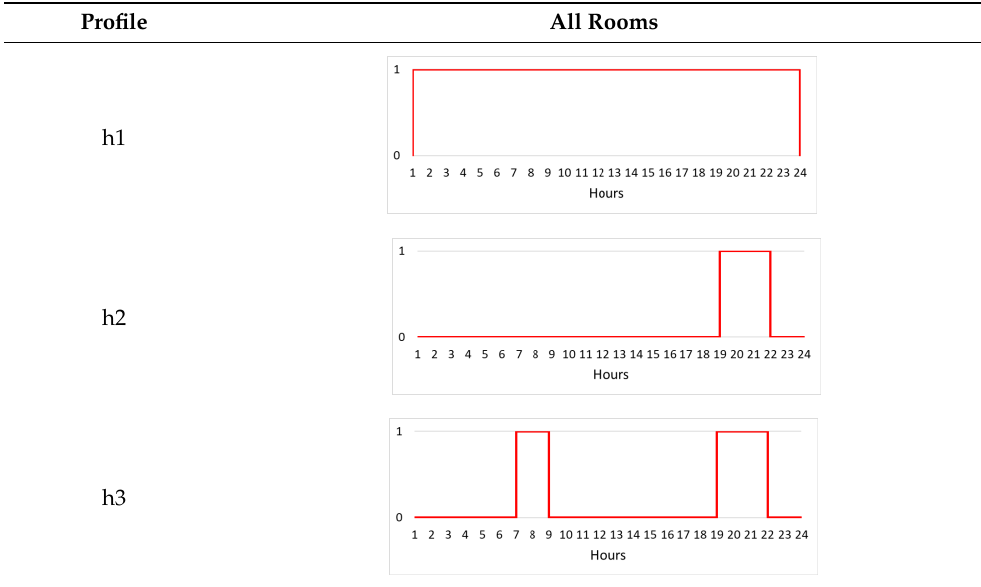
Table 3. Daily natural ventilation schedules in winter (Open = 1, Close = 0). Adapted from [33].